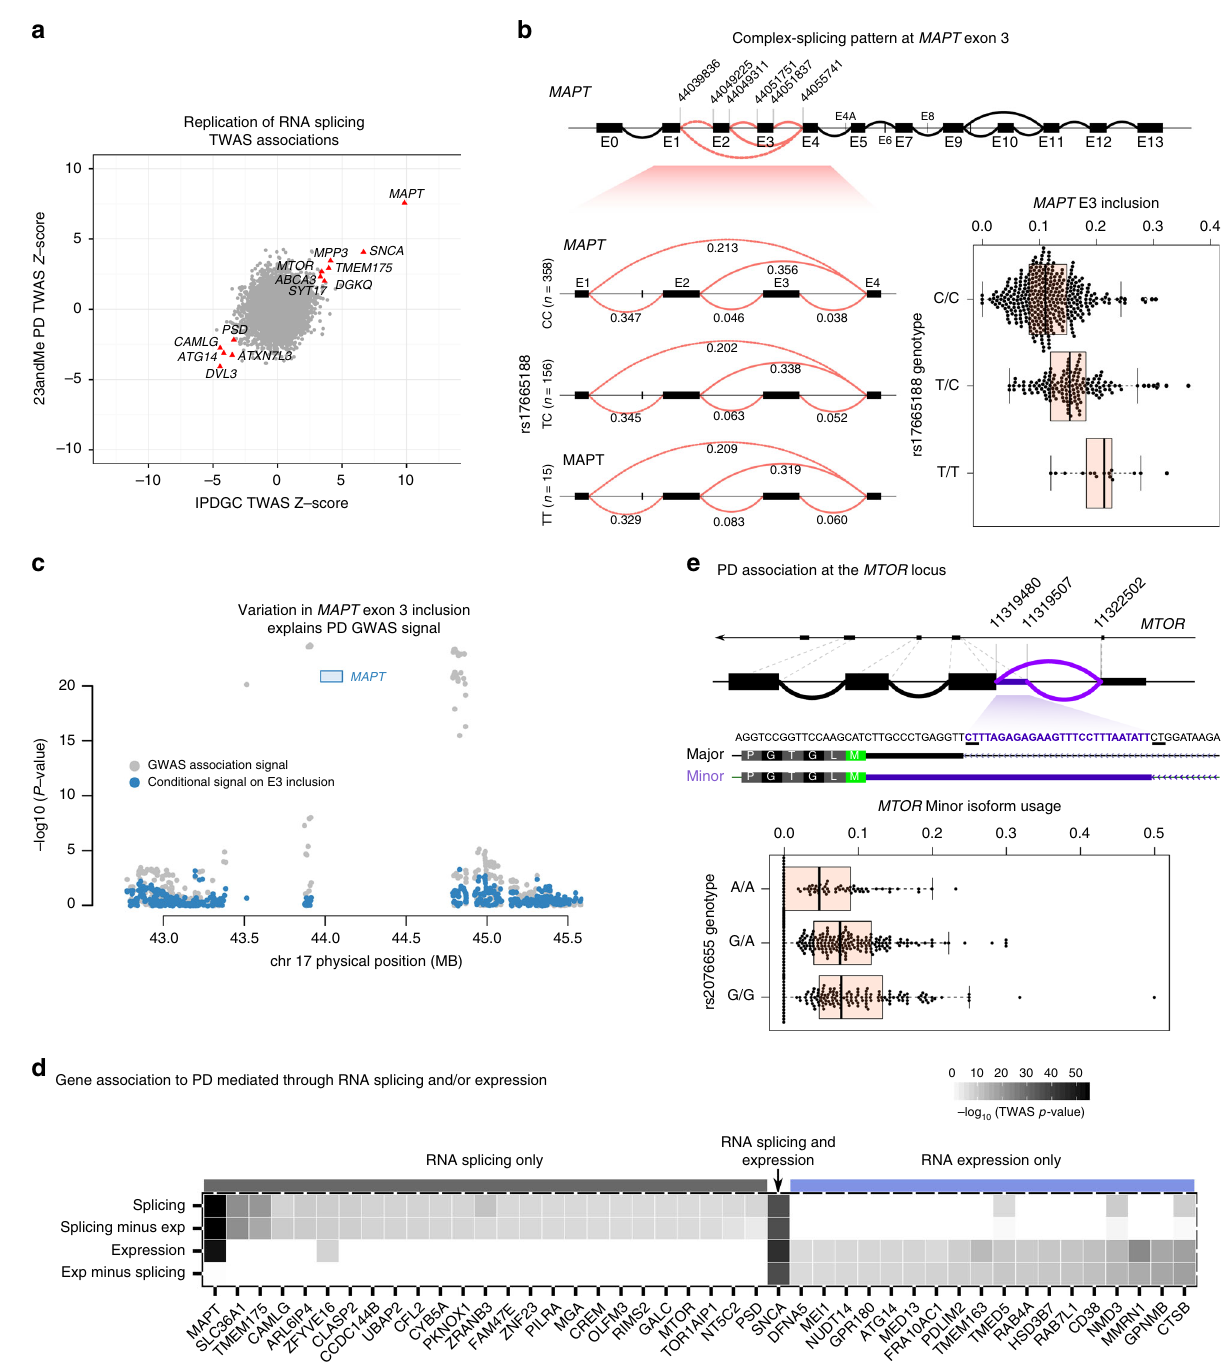
Fig. 3 Parkinson ’ s disease (PD) risk alleles affect splicing of nearby genes. a Replication of transcriptome-wide association study (TWAS) Z -score across two PD cohorts (23andMe and IPDGC). b TWAS signal at the MAPT locus is explained by the single-nucleotide polymorphisms (SNP) rs17665188, which is associated with MAPT exon 3 inclusion levels. rs17665188 tags the known H1/H2 haplotypes, which have been shown to be associated with PD 45 . The T allele, which tags the H2 haplotype, doubles inclusion of exon 3 and is associated with increased risk for PD. c PD TWAS signal at the MAPT locus (gray) and TWAS signal after removing the effect of MAPT exon 3 inclusion (cyan). This analysis shows that the association is largely explained by MAPT exon 3 inclusion. d Heatmap of genes identi fi ed from our TWAS analysis using imputed RNA splicing and expression (splicing and expression, respectively). The rows “ splicing minus exp ” and “ exp minus splicing ” denote association strengths after conditioning on expression and splicing, respectively. SNCA is the only gene associated with PD through both a genetic effect on RNA splicing and expression. e PD-associated variants at the MTOR locus are associated with an increase in a minor MTOR isoform that extends the 5 ′ of an exon in the 5 ′ -untranslated region (5 ′